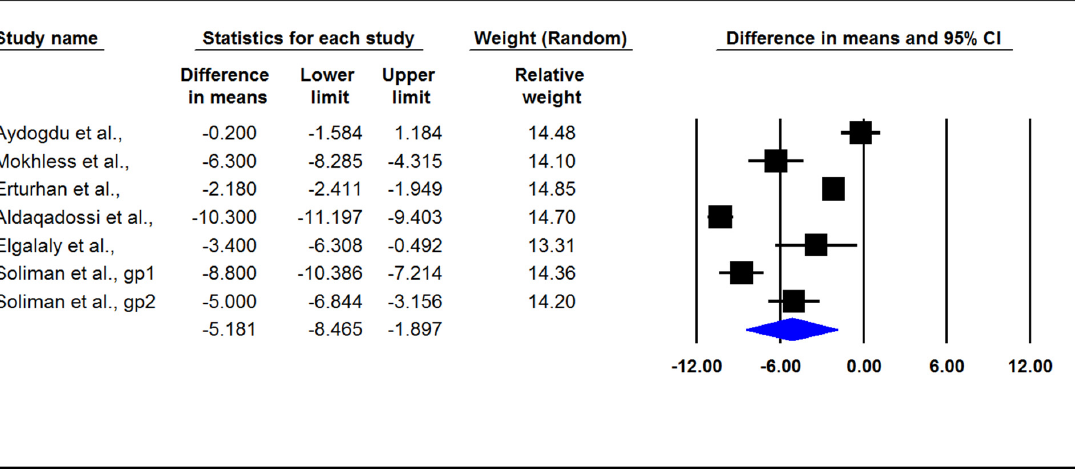
Figure 3. Forest plot for the risk ratios of the stone expulsion rate [3,12–16].